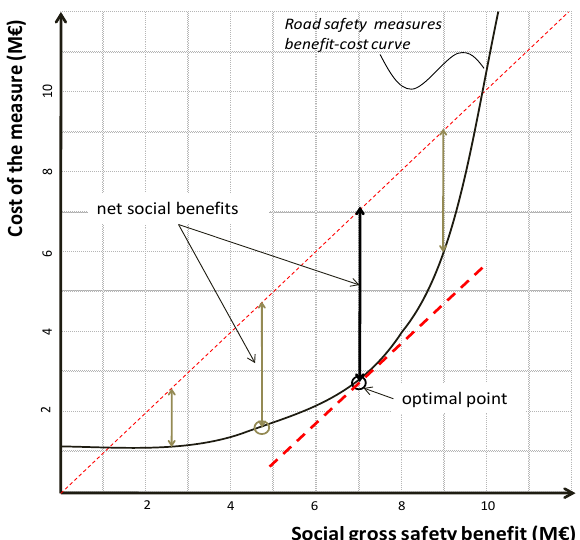
Figure 3. Optimal point for road safety